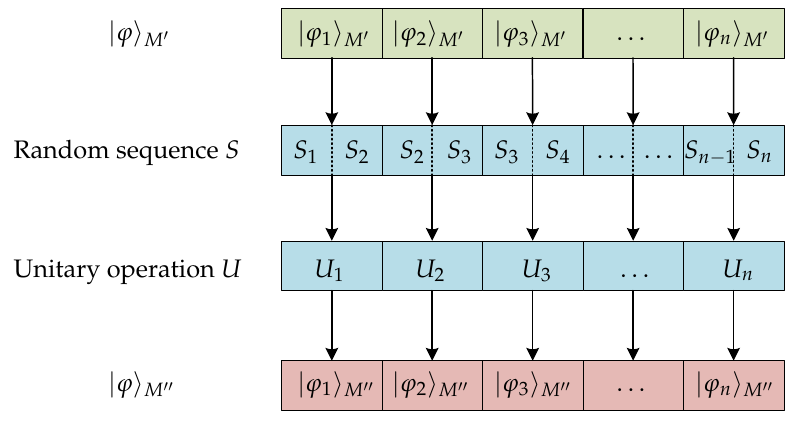
ϕ with unitary operation U governed by the random sequence S to Figure 3. Alice packages Figure 9. Schematic of the designed quantum proxy signature scheme | (cid:105) M (cid:48) ϕ obtain | (cid:105) M (cid:48)(cid:48)